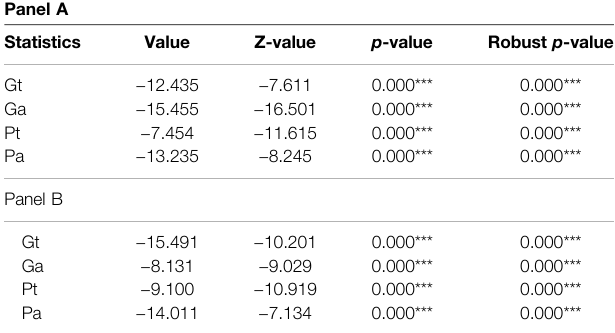
TABLE 5 | Westerlund (2007) bootstrap test.